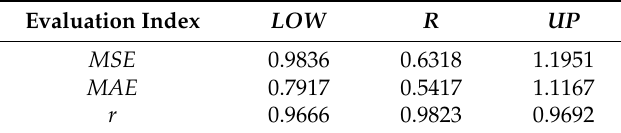
Table 5. Prediction